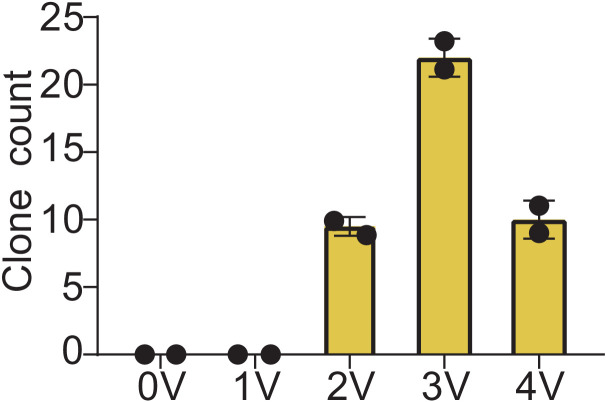
MitoPunch generates stable isolated mitochondrial recipient (SIMR) clones in immortalized mouse cells.Quantification of crystal violet stained B16 ρ0 SIMR clones formed by MitoPunch transfer of isolated L929 mitochondria actuated with indicated voltages after SIMR cell selection. Error bars indicate the range between the technical duplicates.